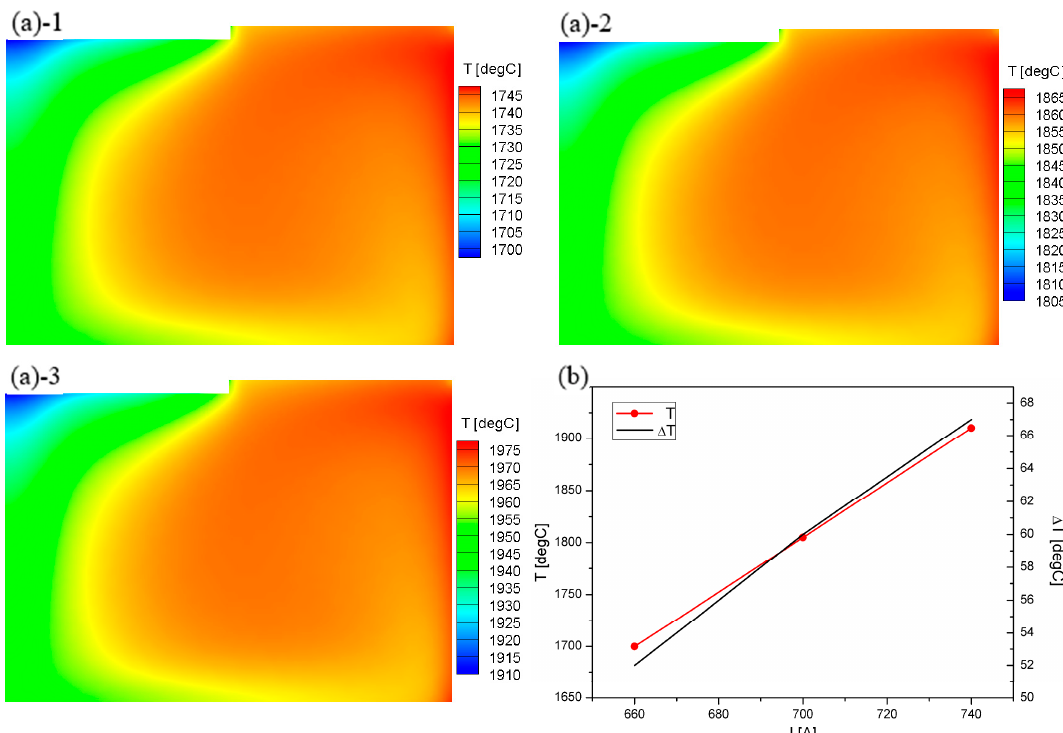
Figure 2. ( a ) Solution internal temperature distribution. 1,2,3 correspond to the coil current 660 A, 700 A and 740 A, respectively. ( b ) Variation in the minimum temperature and maximum temperature difference of the solution with the current. T is the minimum temperature, I is the coil current, and △ T is the maximum temperature difference.